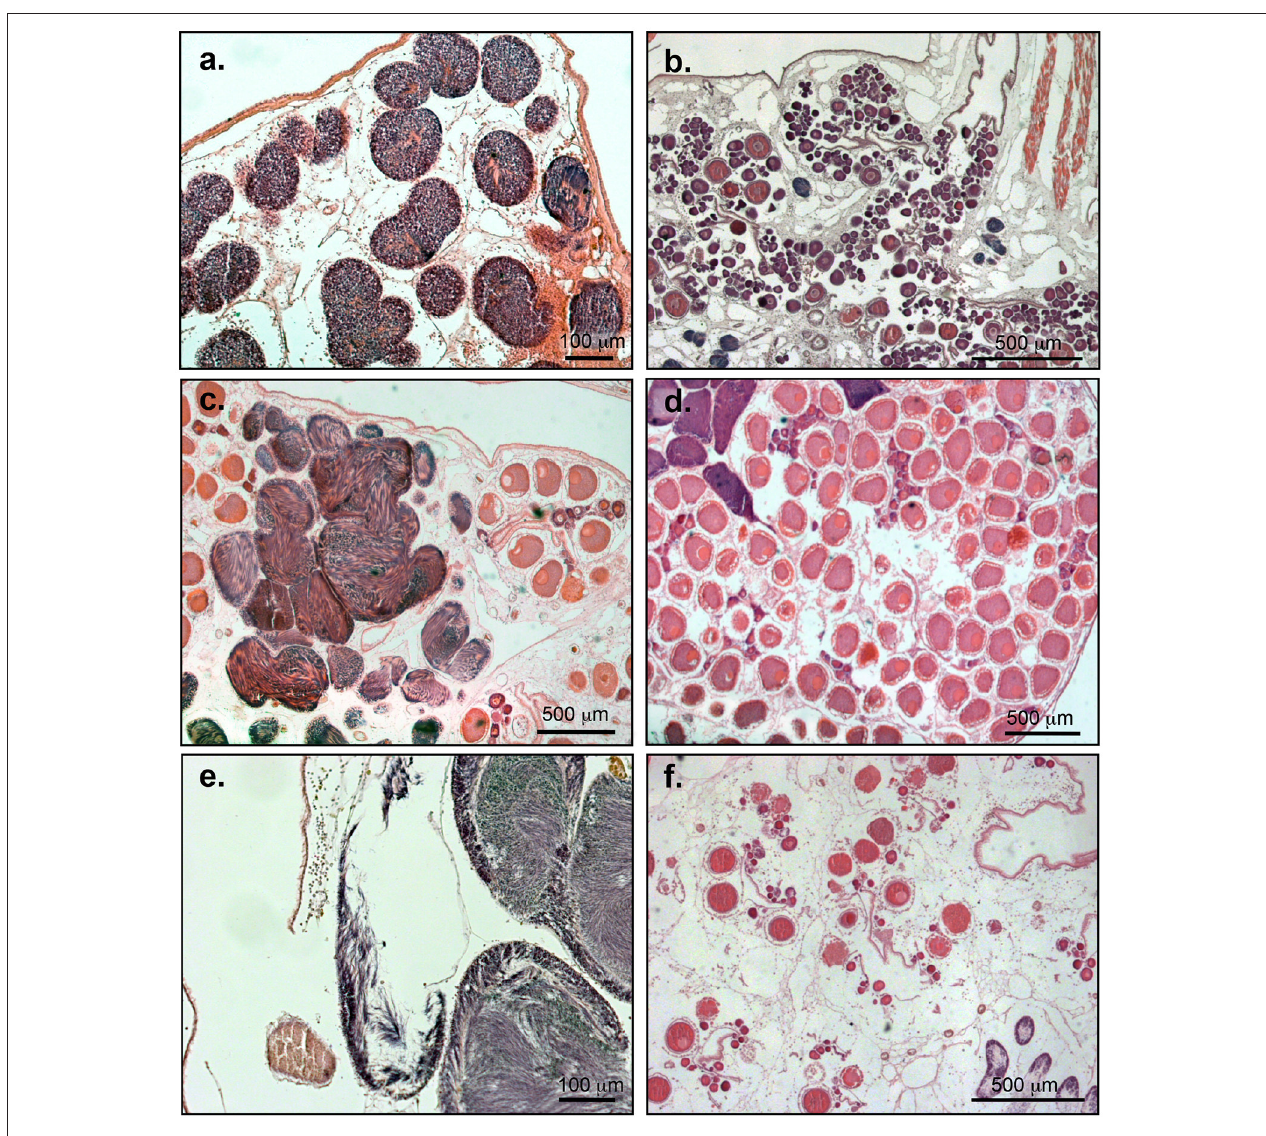
FIGURE 3 | Microcosmus exasperatus . Light micrograph of the gonad developmental stages. (A) Immature sperm follicles stage I, scale bar = 100 µ m. (B) Developing ova with various developmental stages of oocytes. (C) Male follicles at ripe stage II filled with spermatozoa. (D) Ripe ova with full-size oocytes. (E) Spawned sperm follicles, partially empty, stage III. (F) Ova after spawning, immature oocytes can be found beside residual